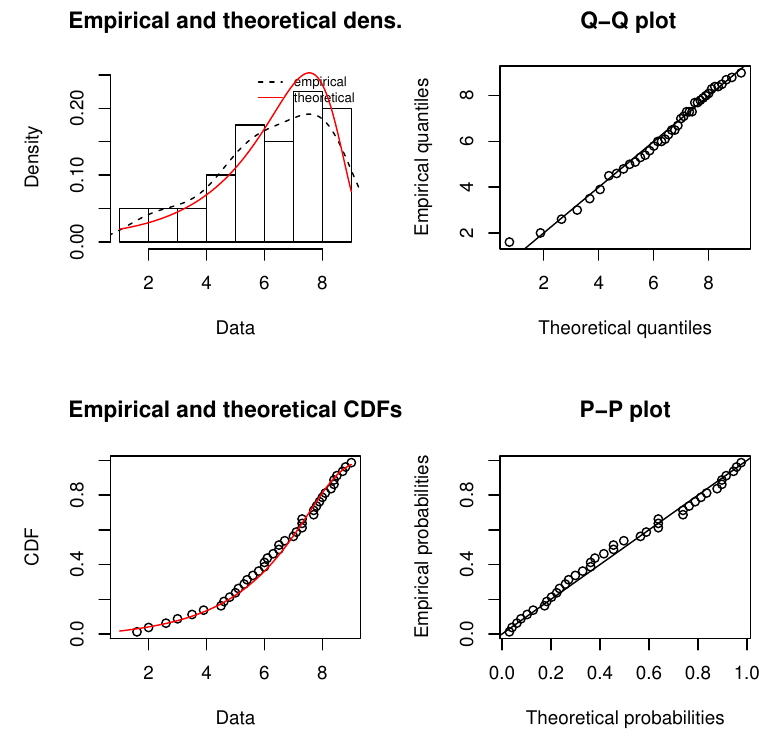
Figure 3. PP, QQ, epdf and ecdf plots of the MBGz distribution for Dataset